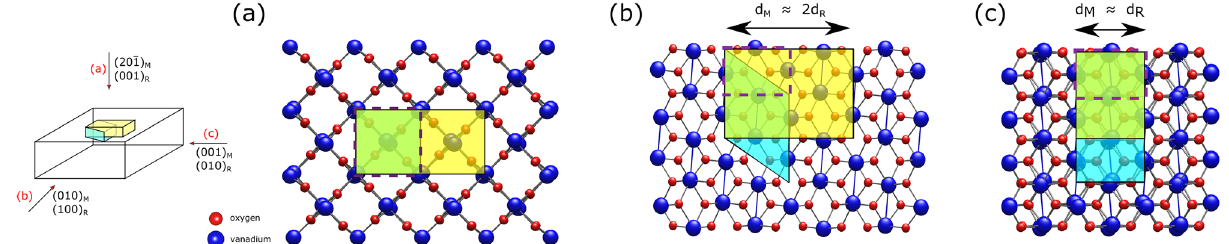
2 ) periodicity is expected with ×